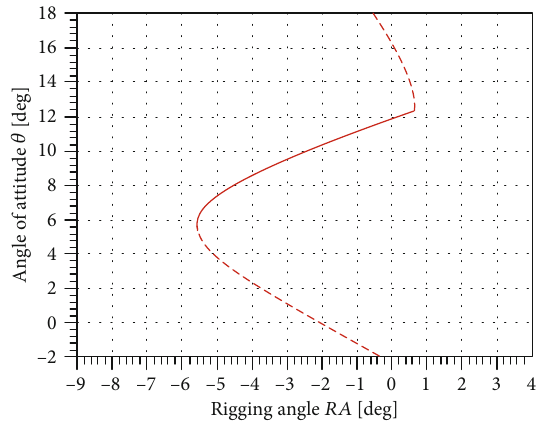
Figure 9: The relation between rigging angle and the angle of attitude in the stable fl ight points.